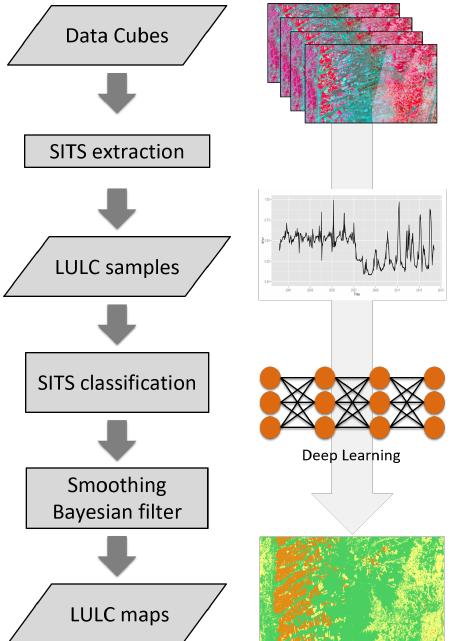
Figure 9. Process to create land use and land cover (LULC) maps from Earth observation (EO) data cubes using satellite image time series (SITS) analysis and deep learning methods.